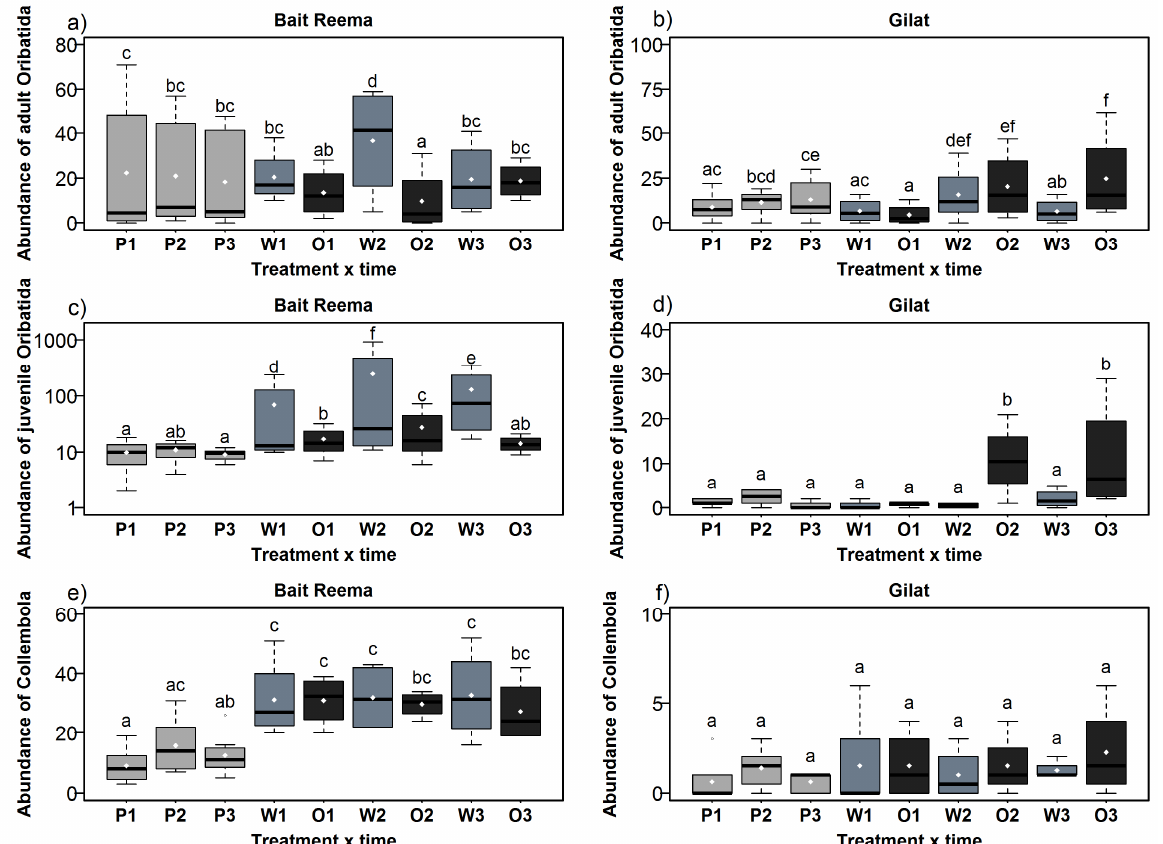
Figure 2. Box-and-whisker plots of Oribatida and Collembola abundances in different treatment groups and time in Bait Reema and Gilat. P, pre application plots; W, water- treated plots; O, OMW-treated plots at the 1st, 2nd and 3rd sampling interval. White dots show mean values. Mean values followed by the same letter are not statistically